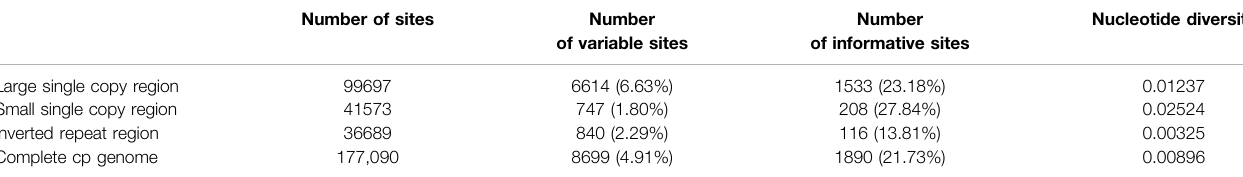
TABLE 3 | Variable and informative site analyses in the nine Paphiopedilum cp